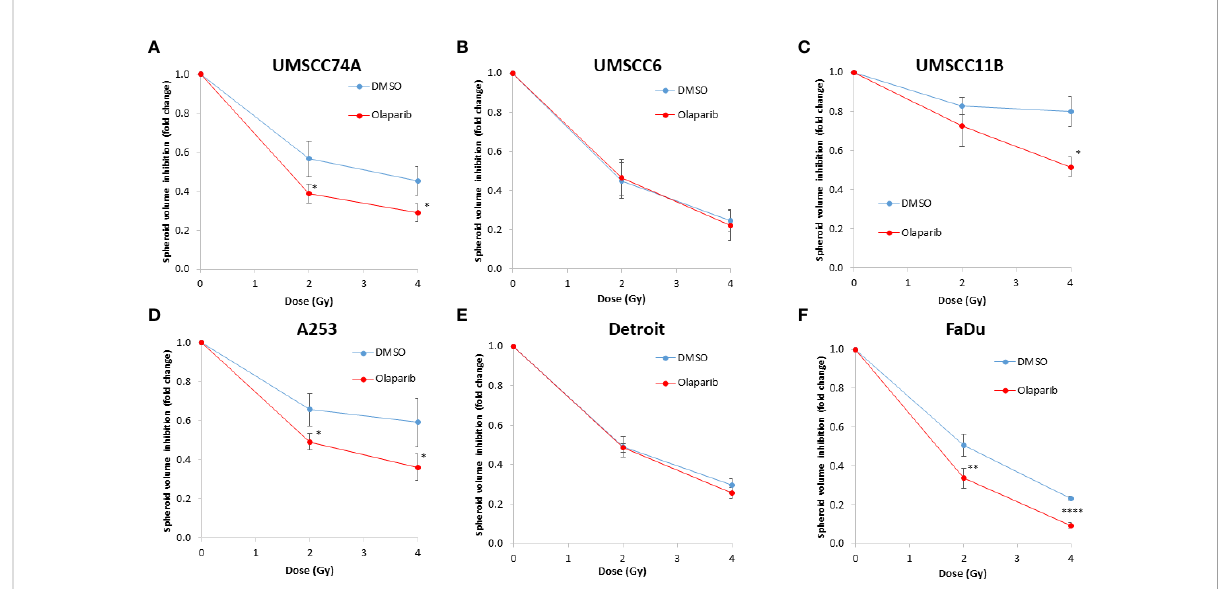
FIGURE 8 Impact of olaparib on the enhancement of the radiosensitivity of HPV-negative HNSCC spheroids to protons. (A – F) The fold growth of HPV-negative HNSCC spheroids from days 3 to 11 post-seeding was determined relative to the proton dose, and this was normalised to the unirradiated control which was set to 1.0. *p < 0.05, **p < 0.02, ****p < 0.001 as analysed by a two-sample t-test.